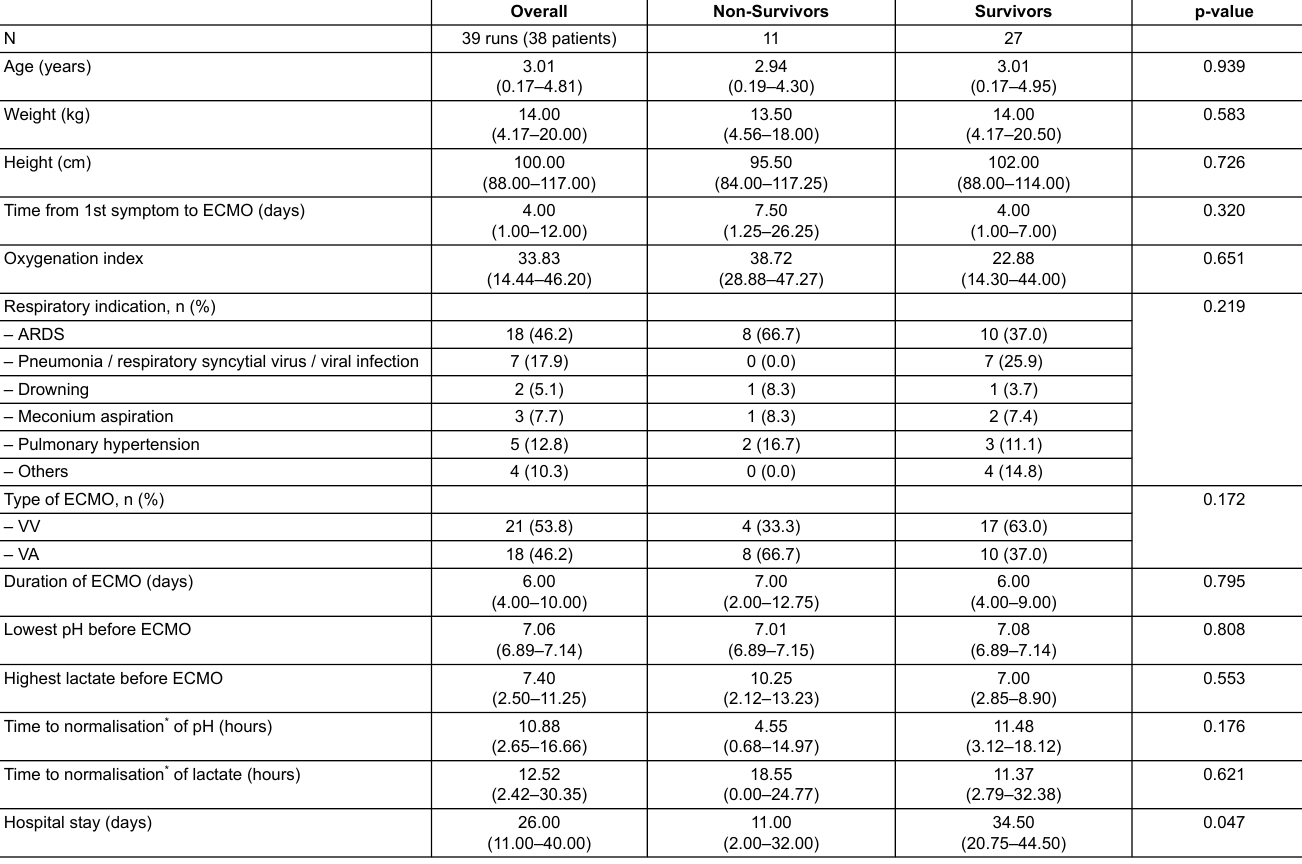
Table 1: Descriptive analysis of the